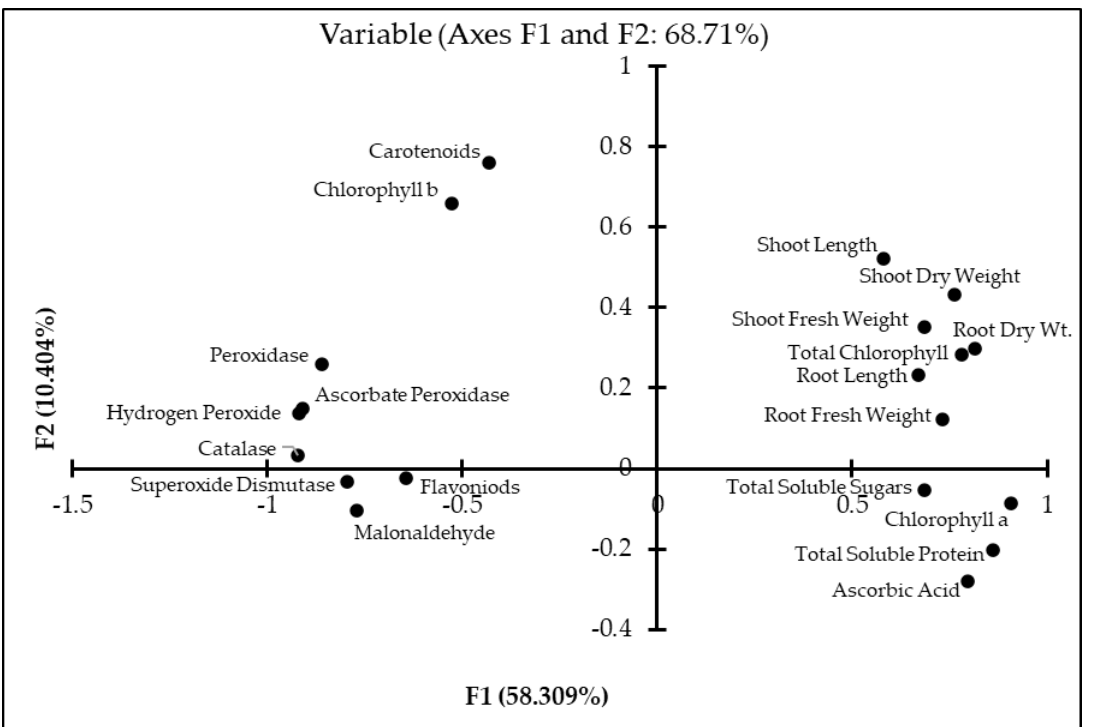
Figure 5. Principal component analysis (PCA) of studied attributes of maize inoculated with Bacillus spp. strains under drought stress.